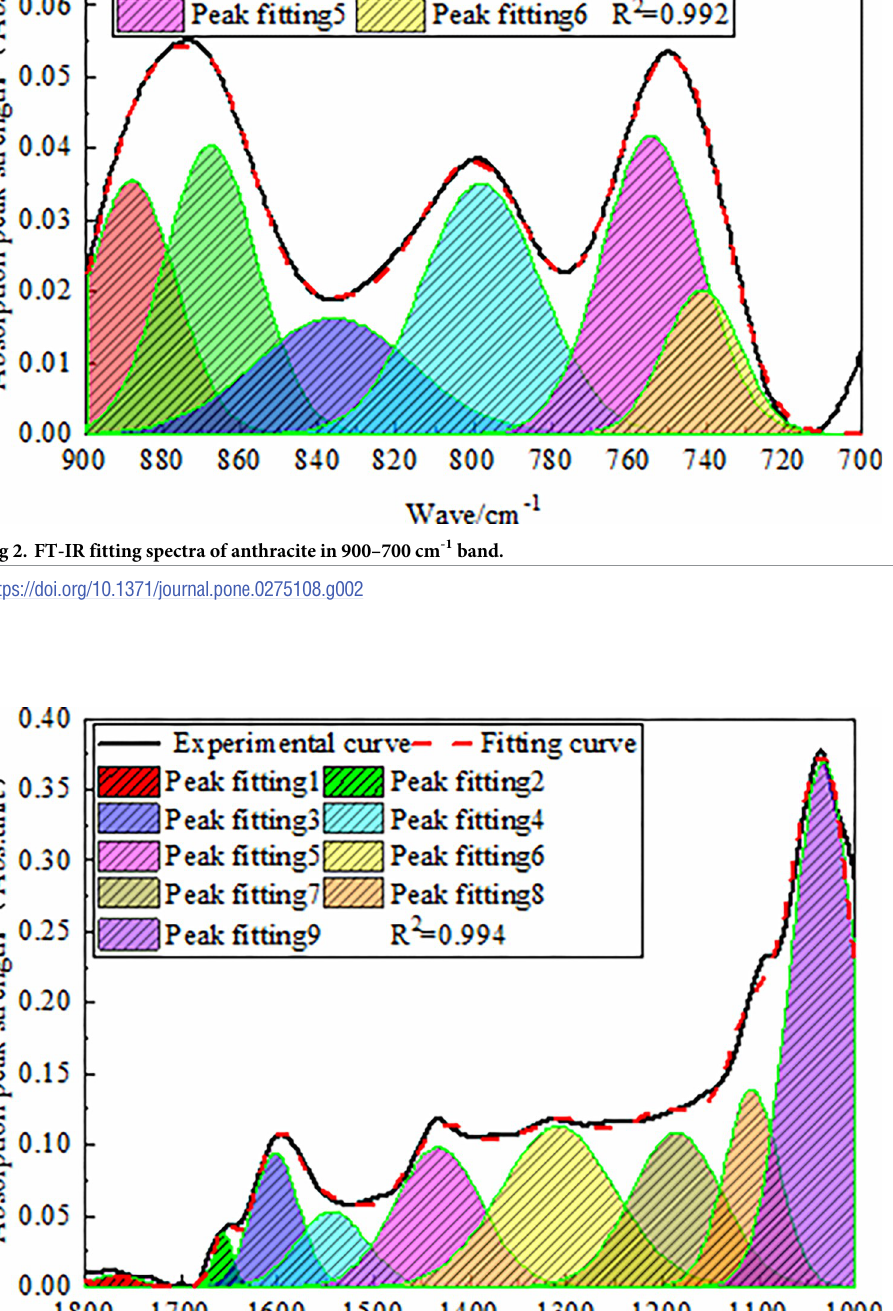
PLOS ONE | https://doi.org/10.1371/journal.pone.0275108 September 28,